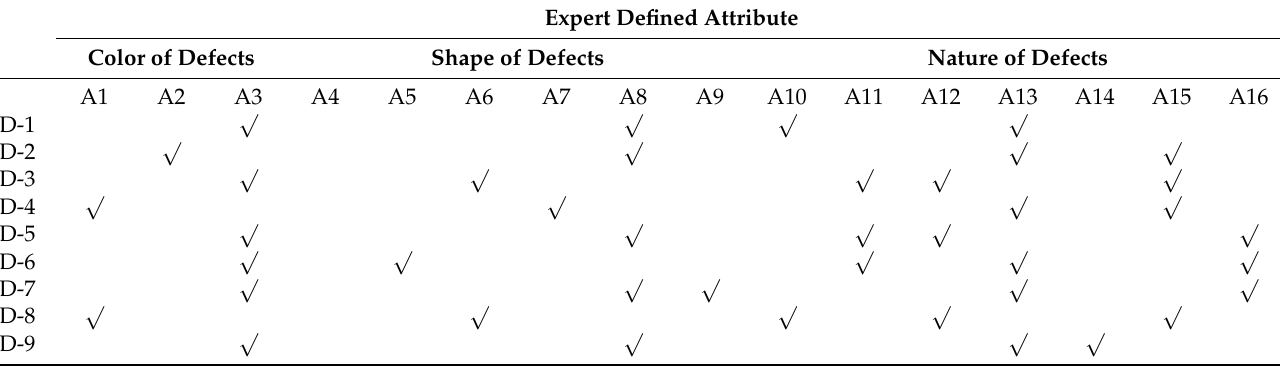
Note: A1 = white, A2 = brown, A3 = dark gray, A4 = round, A5 = droplet shape, A6 = granular, A7 = linear, A8 = irregular shape,